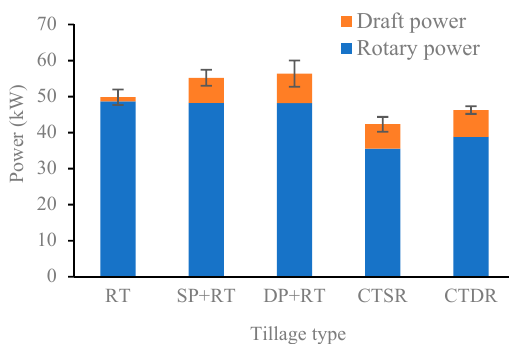
Figure 6. Power characteristics of different tillage type in the rice field experiment. (Bar graph represents the mean value, and error bars represent standard deviations).